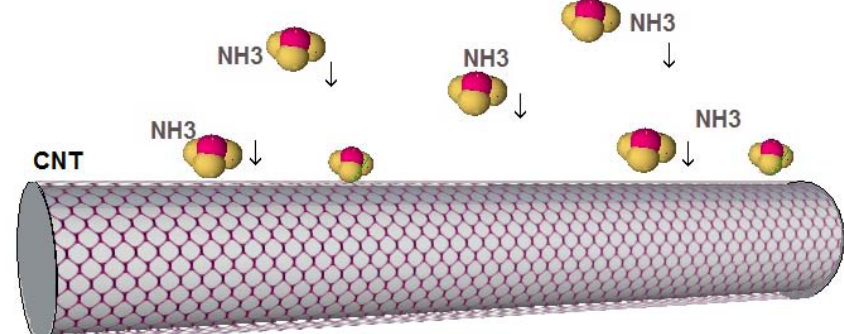
Figure 3. Gas adsorption mechanism; NH